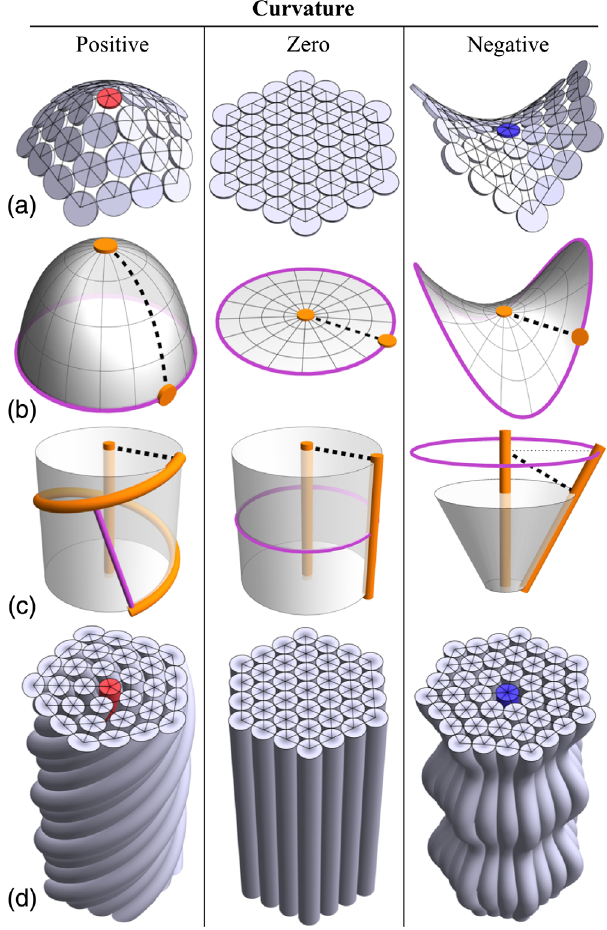
FIG. 1. (a) A flat flexible crystalline membrane will buckle into a positively curved dome (left) or negatively curved saddle (right) in response to the insertion of a fivefold (red) or sevenfold (blue) disclination. (b) The differing geometries can be characterized by comparing the radial distance between two disks R (dashed black line) and the circumferential distance from an outer disk to itself C (solid purple line). For a flat surface, C ¼ 2 π R (center), but for a positively curved surface, C < 2 π R (left), while a for a negatively curved surface, C > 2 π R (right). (c) Equivalent geom- etries exist for flexible columnar materials when we consider the distance of separation perpendicular to the filaments. A pattern of twist (left) reduces the circumferential distance between filaments (solid purple), similar to a dome. Alternatively, a pattern of splay (right) reduces the radial (dashed black line) distance between filaments, similar to a saddle. (d) Based on these geometries, conjectured structures are shown for a bundle with a fivefold disclination (left) and sevenfold disclination